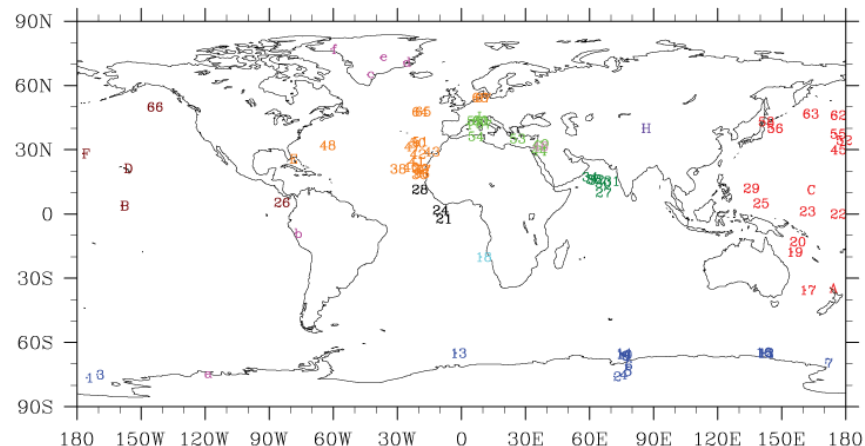
Fig. 12. Location of stations from the compiled dust deposition dataset. Different colors are applied for different regions: West/East Pacific (red/brown), North/Tropical/South Atlantic (orange/black/light-blue), Middle East/Asia/Europe (violet/purple/light green), Indian/Southern Ocean (dark green/dark blue) and pink ice core data in Greenland, South America and Antarctica.